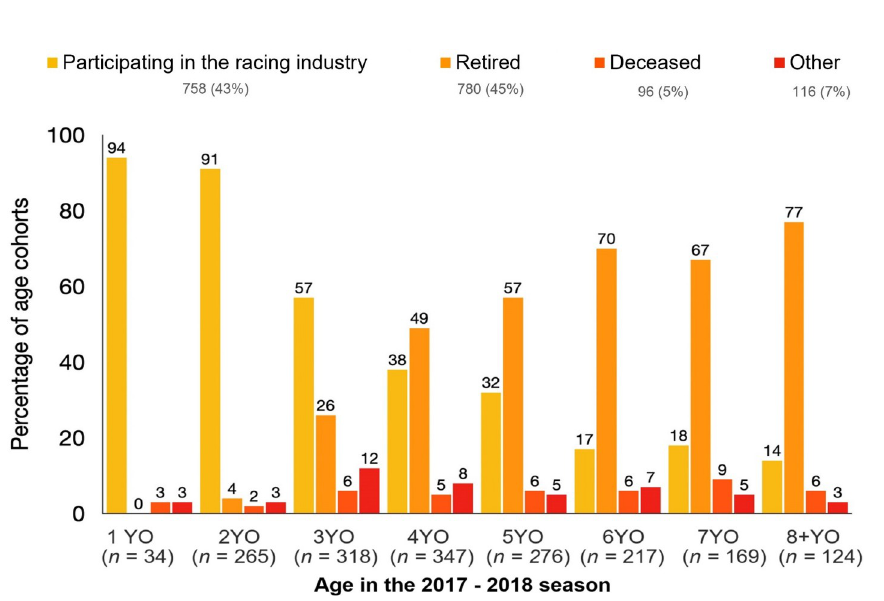
Fig 3. The percentage of survey outcomes by age for 1,750 study horses classified as inactive in the 2017–2018 Australian Thoroughbred racing season. Other: Exported, returned to owner, transferred, sold or unknown.